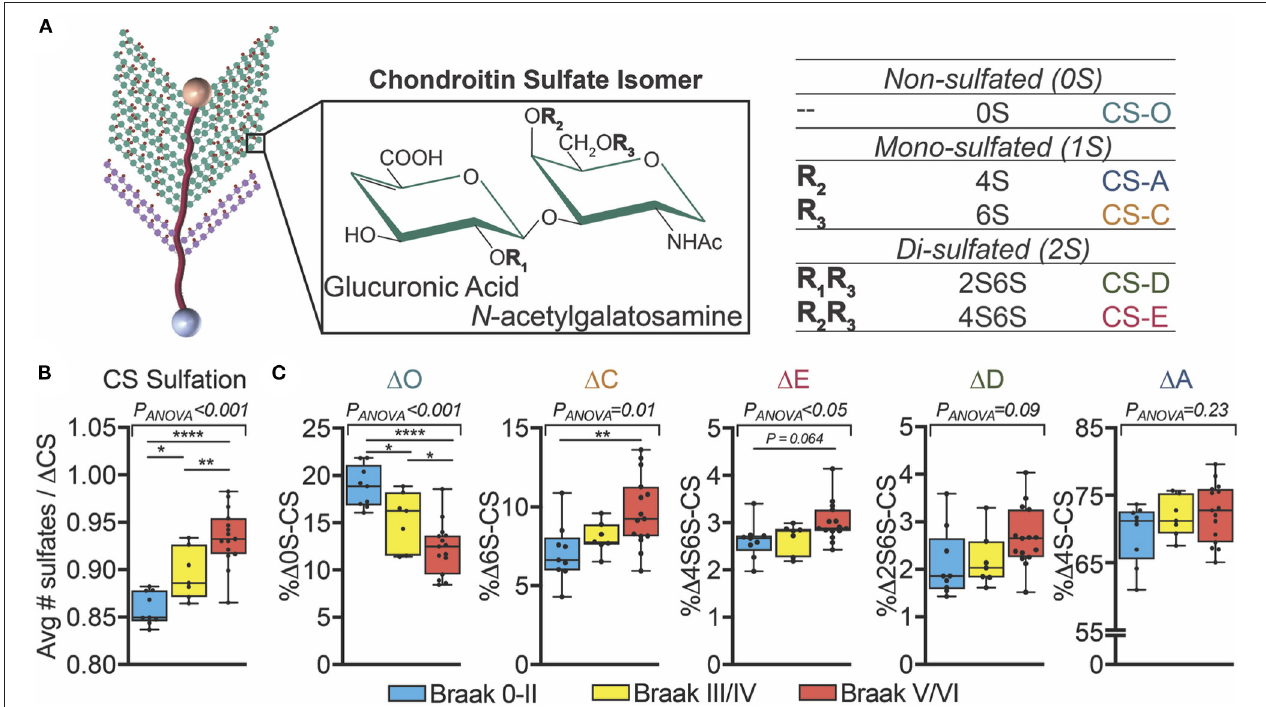
FIGURE 3 | Changes in human AD brain CS-GAG sulfation patterns correlate to Braak stage. (A) PNN attached CS-GAGs are comprised of five key CS isomers including CS-O (0S), CS-A (4S), CS-C (6S), CS-D (2S6S), and CS-E (4S6S), which differ by the number of sulfation attachments (non- (0S), mono- (1S), and di- (2S) sulfated variants). The relative abundance of each isomer incorporated into the PNN matrix comprises a “CS-GAG sulfation code” that can influence both PNN stability and function. (B,C) Demented (AD) and non-demented (controls) were separate by Braak pathology including Braak 0-II ( blue , controls), Braak III/IV ( yellow , controls), and Braak V/VI ( red , AD) (see Logsdon et al., 2021). (B) Hypersulfation of the CS-GAGs and changes in (C) the relative abundance of each CS isomer isolated from the middle frontal gyrus correlates to Braak stage (see Logsdon et al., 2021). * p < 0.05, ** p < 0.01, **** p < 0.0001. CS, chondroitin